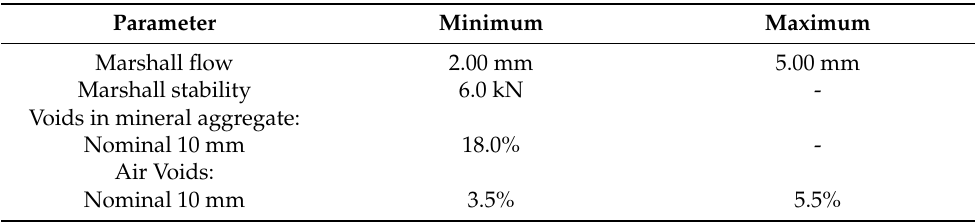
Table 8. Marshall test parameters from MRWA specifications 502 Reprinted from ref. [4].